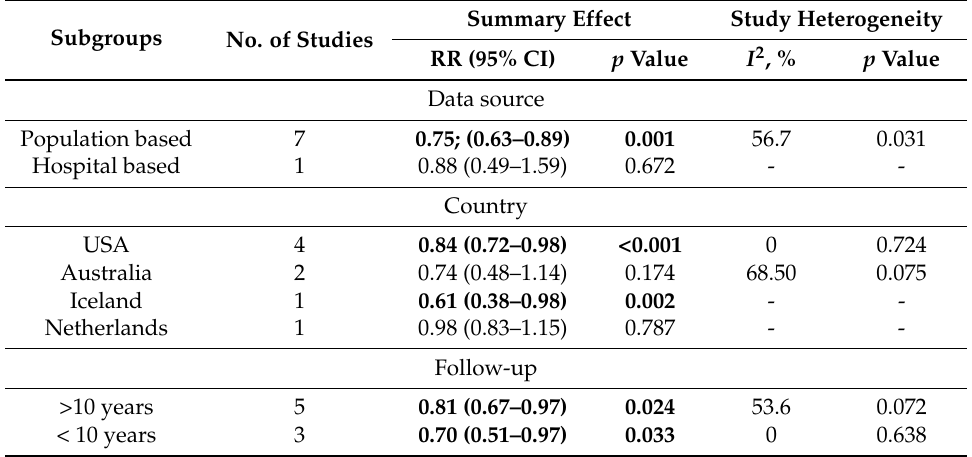
Table 2. Subgroup analysis of fish consumption and risk of AMD with combined relative risks (RR).